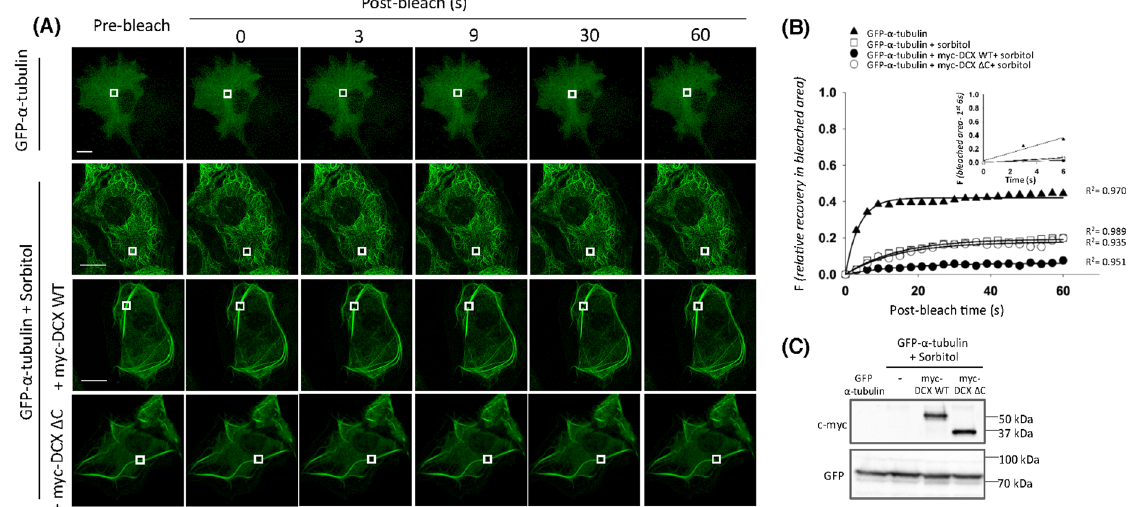
Figure 7. FRAP analysis reveals that hyperosmotic stress conditions affect GFP- α -tubulin exchange dynamics. COS-1 cells were transfected to express ( A ) GFP- α -tubulin, GFP- α -tubulin together with myc-DCX WT or GFP- α -tubulin together with myc-DCX Δ C and then exposed to sorbitol (0.5 M, 1 h) as indicated to induce hyperosmotic stress. A FRAP protocol with a small bleach area and measuring recovery into the bleached area was utilized ( A , B ). A small ROI (indicated by the white rectangle in each cell image) was photobleached in ( A ) and the fluorescence recovery subsequently monitored at 3 s intervals for 60 s. ( B ) Plots of the recovery of fluorescence in small area of bleach in GFP- α -tubulin with or without myc-DCX constructs in the presence and absence of sorbitol treatments are shown. Regression values for the accuracy of the respective curve fits are shown. Insets represent the recovery of fluorescence in bleach area for first three time-points (0–6 s of post- bleach) with the line of best fit used for the calculation of initial rate. ( C ) Equivalent expression of the GFP- α - tubulin and myc-DCX constructs was detected in the presence and absence of sorbitol by immunoblotting for c-myc (upper panel) and GFP (lower panel). Scale bars represent 10 µ m. See Fig. 8 for quantitative pooled data.